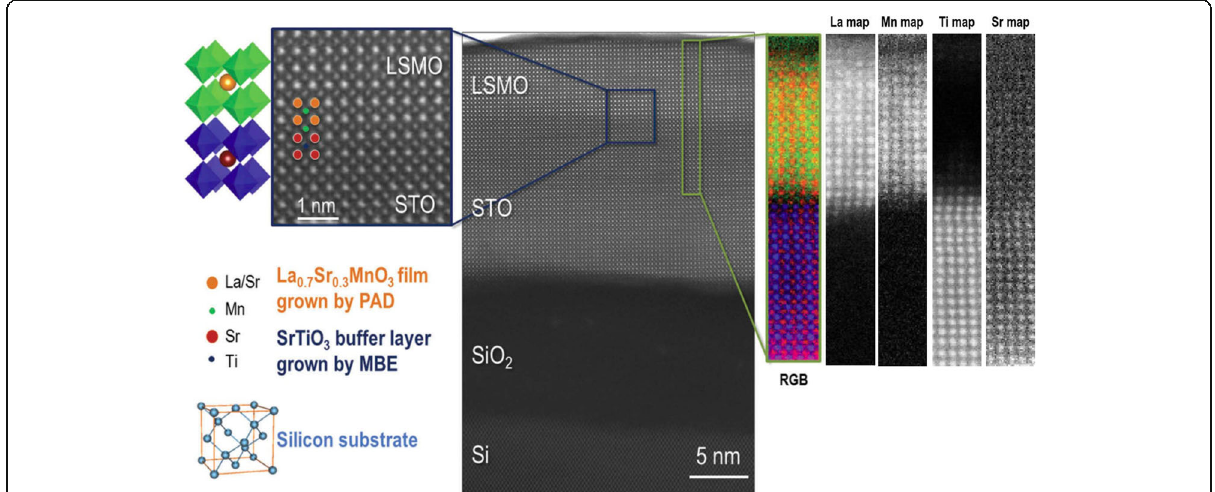
Fig. 11 Atomic resolution Z-contrast image of epitaxial La 0.7 Sr 0.3 MnO 3 (LSMO) PAD /SrTiO 3 (STO) MBE /Si heterostructure viewed along the [100] direction. Detail of the Z-contrast image showing the coherent interface between the LSMO and the STO/Si buffer layers (left image). EELS image (right): color elemental mapping produced by overlaying the Mn L2,3 (green), Ti L2,3 (blue), Sr M4,5 (red), and La M4,5 (orange) elemental maps, displaying a high-quality chemical interface between the STO and LSMO layer, the structure of which is sketched in the left of the image, respectively. Reproduced with permission of